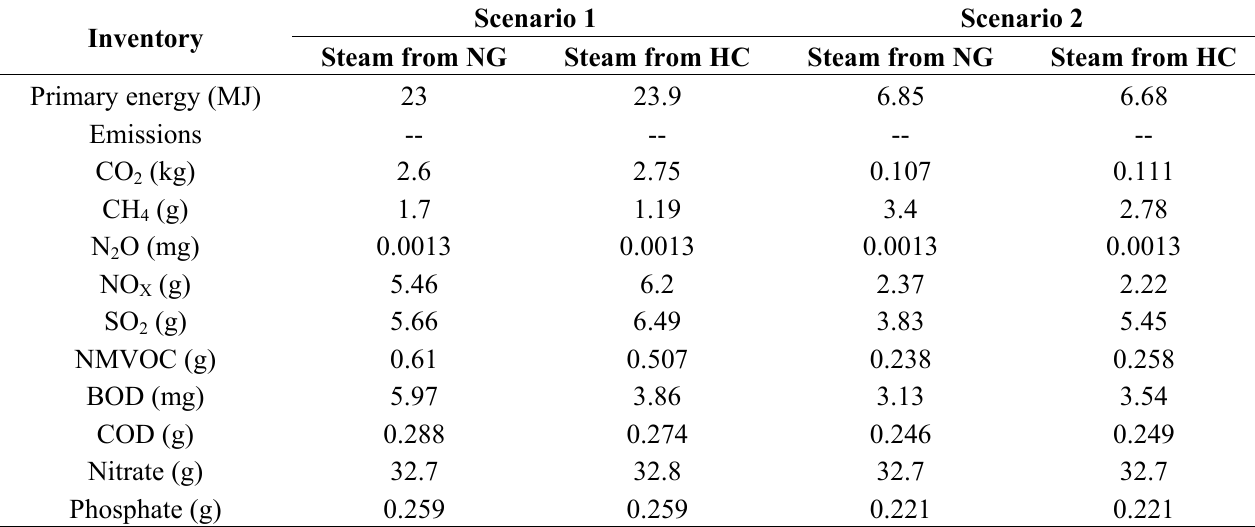
Table 3. Life-cycle inventory for production of 1kg anhydrous ethanol in Blenke cascade system.